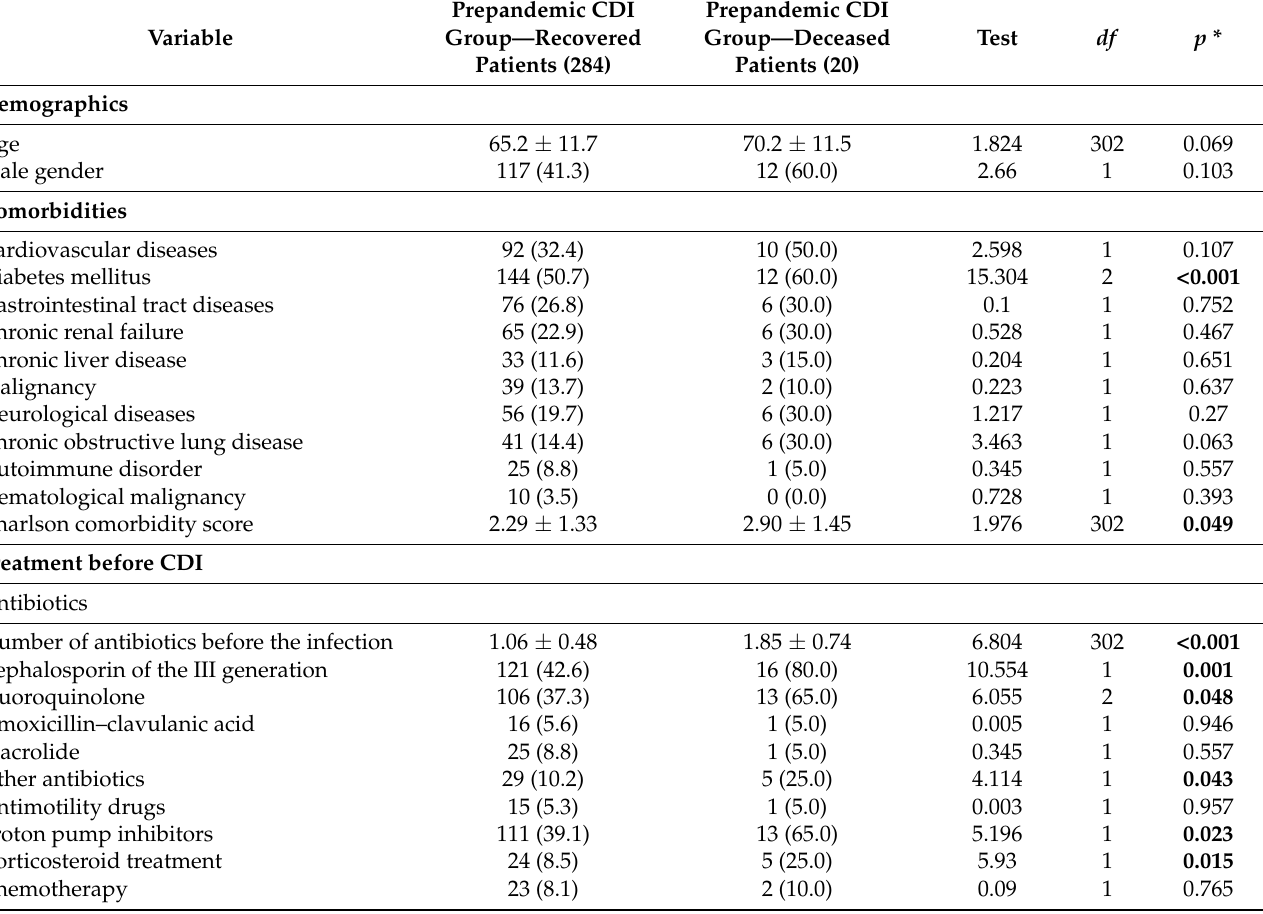
Table 2. Demographic characteristics, previous and concomitant medication use, and laboratory parameters at the time of CDI diagnosis in surviving and deceased patients in the prepandemic CDI